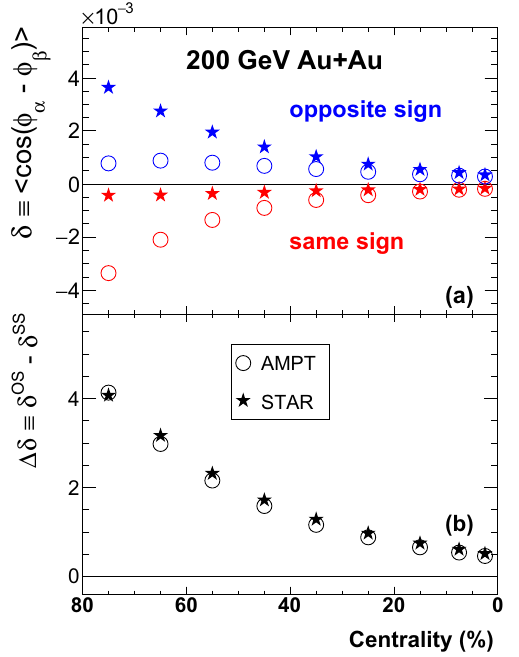
Fig. 2 Two-particle correlations δ SS , δ OS (upper) and (cid:8)δ (lower) as functions of centrality for AMPT and STAR results [15] in Au+Au √ s NN = 200 GeV collisions at